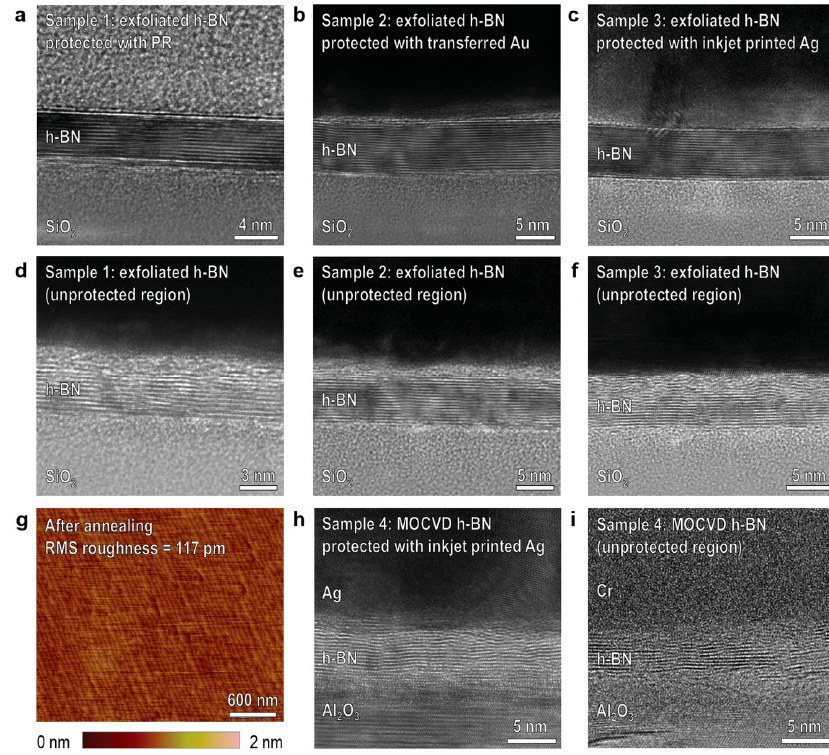
Figure 7. ( a – c ) TEM images of samples 1, 2, and 3 protected by negative photoresist, Au electrode, and inkjet-printed AG ink, respectively. ( d – f ) TEM images of samples 1, 2, and 3 covered by electron-beam-deposited Au. ( g ) Topographic AFM map of the surface of the Al 2 O 3 after annealing. ( h , i ) The cross-sectional TEM images of the MOCVD h-BN sample at ( h ) a location previously protected with inkjet-printed Ag, and ( i ) is unprotected. Adapted with permission from [93]. Copyright © 2021 Wiley-VCH GmbH.